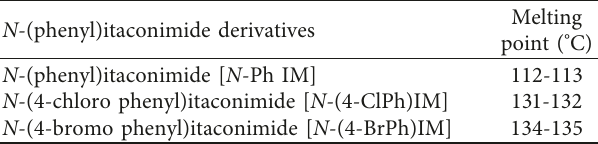
Table 1: Melting points of various N -(halo phenyl)itaconimides. N -(phenyl)itaconimide derivatives